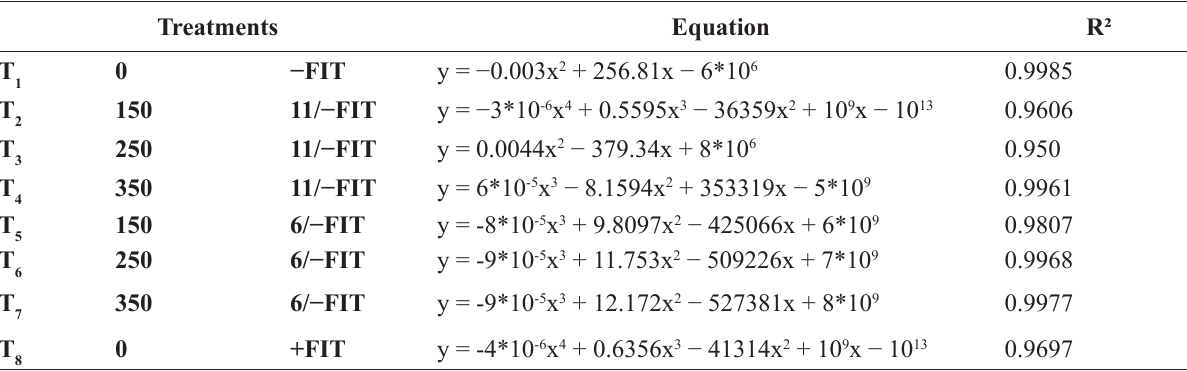
Table 3. Equations of the curves of inflorescence appearance in the experiment with pineapple cv. ‘MD2’ in